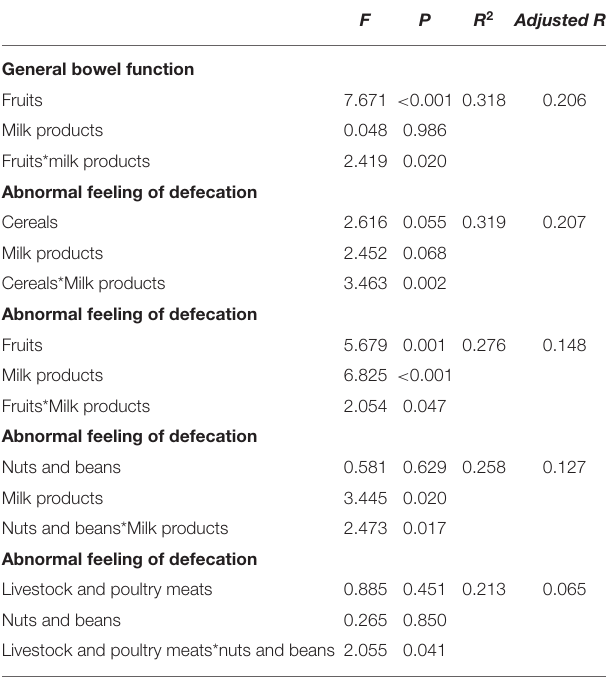
TABLE 3 | Two-way ANOVA of interaction effect between different foods on bowel symptoms.